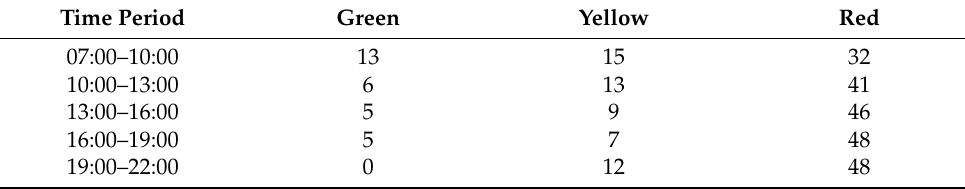
Table 5. Color per time period.